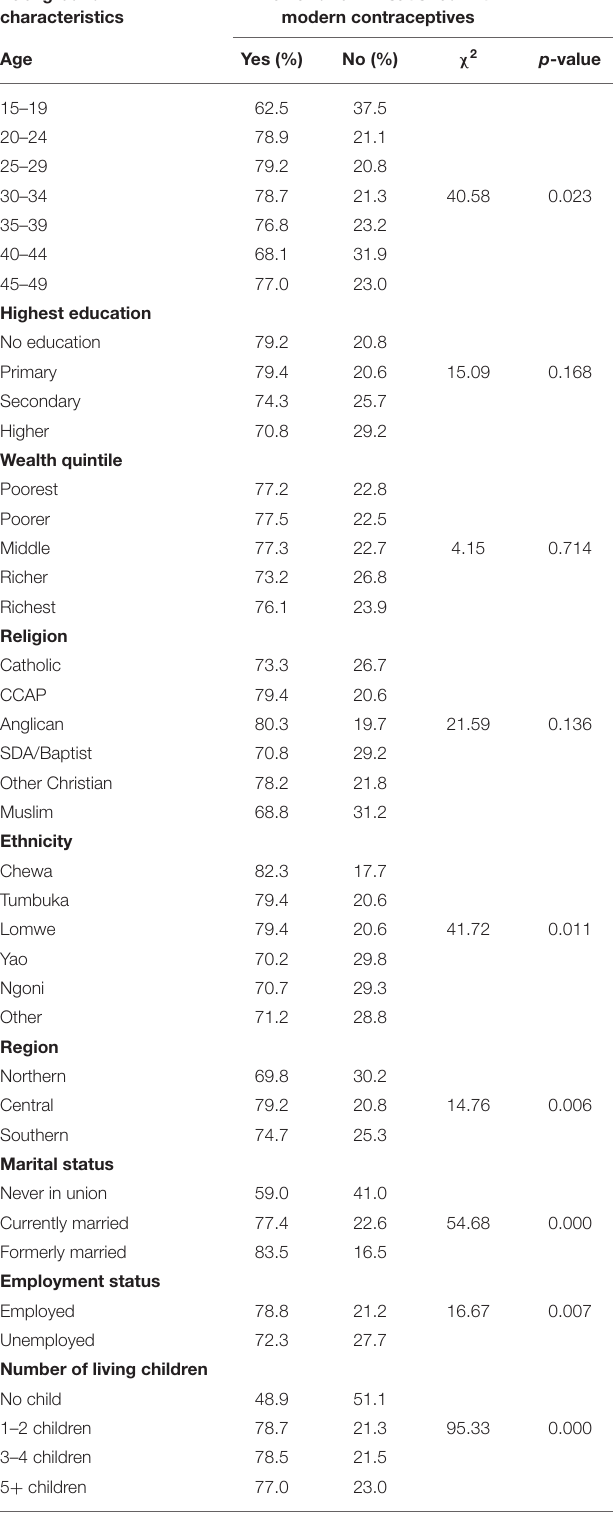
TABLE 3 | Association between mDFPS and socio-demographic and reproductive characteristics of all urban women in Malawi. Background